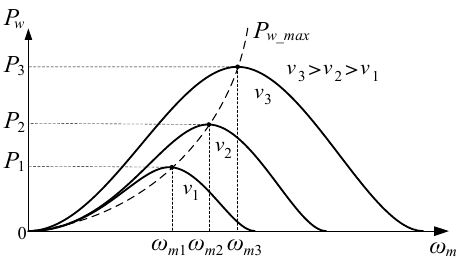
Figure 1. Wind turbine power-rotor speed characteristic curves at different wind speeds.